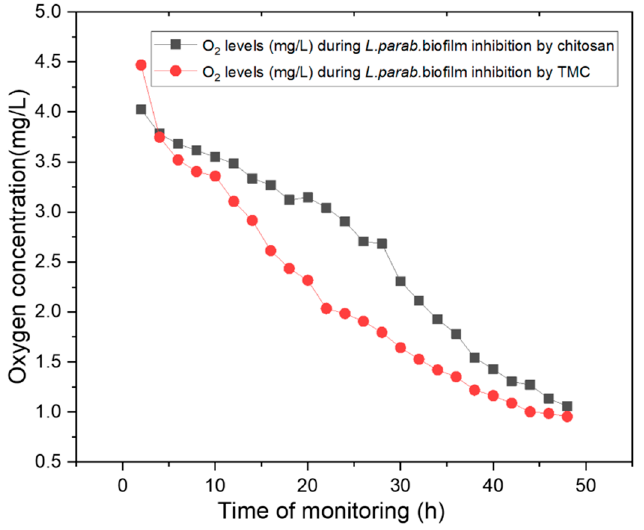
Figure 5. Concentration profiles for oxygen during bacterial detachment at the ATR waveguide surface at a constant flow of chitosan and TMC inhibition were determined via an oxygen optical sensor spot attached to the ATR waveguide surface. The results shown are the averages of three replicative oxygen concentration measurements.